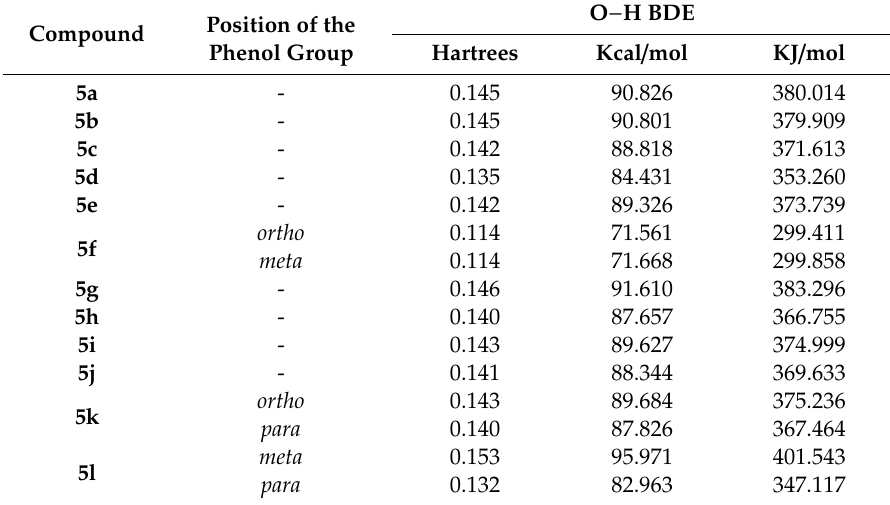
Table 6. The computed O − H Bond Dissociation Energies (BDE) from the compounds 5a – l .